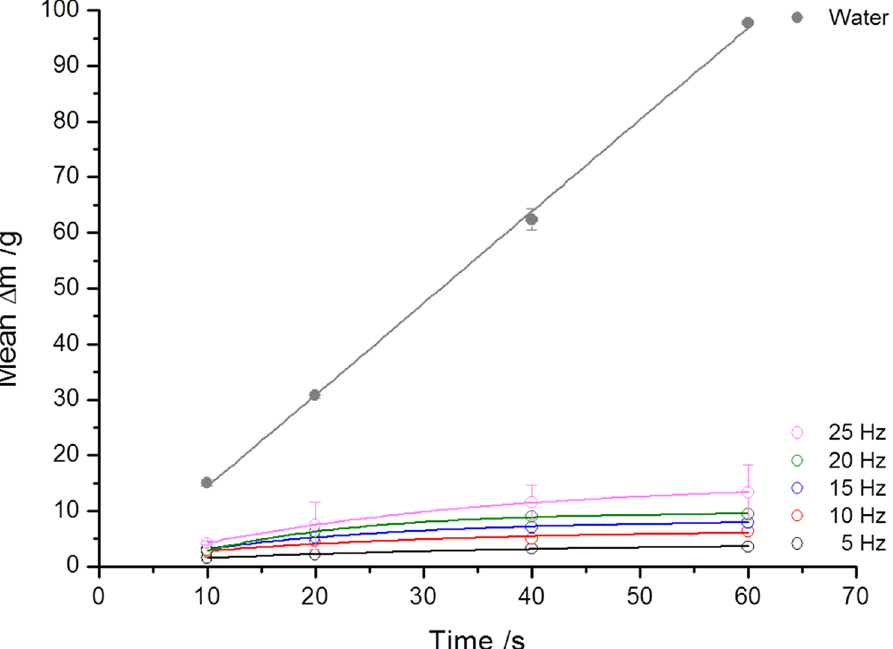
Figure 3. Using the example of Fig. 2a, a comparison of the results of porcine vitreous body aspiration with that of water as reference material using Mark I handpieces. The difference in the aspiration rate is approximately one order of magnitude. Corresponding cut rates are also given in Fig.